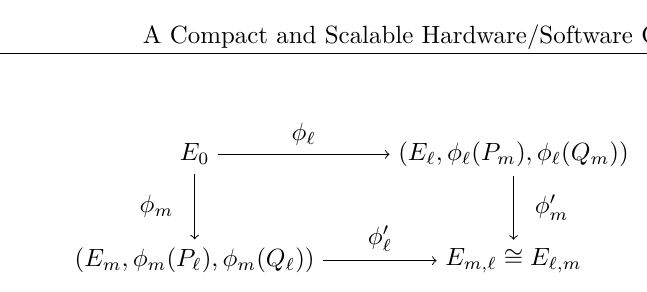
Figure 1: Supersingular isogeny Diffie-Hellman key exchange